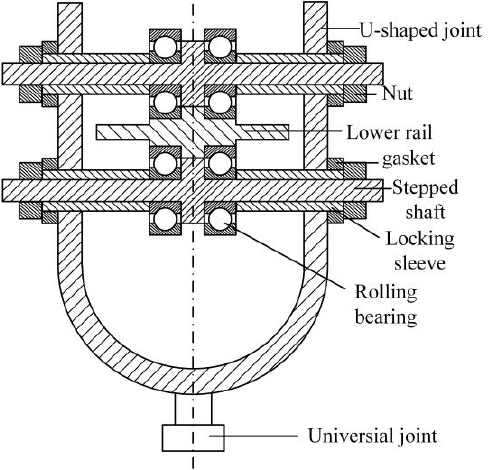
Figure 18. Partial sectional view of connecting structure.